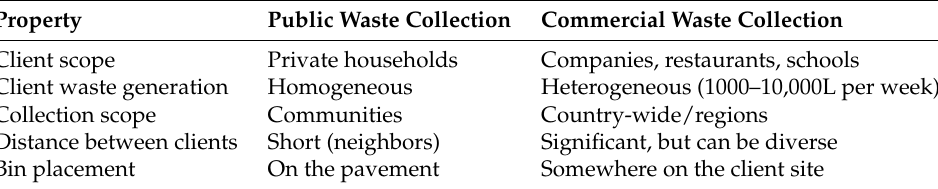
Table 1. Differences between Public and Commercial Waste